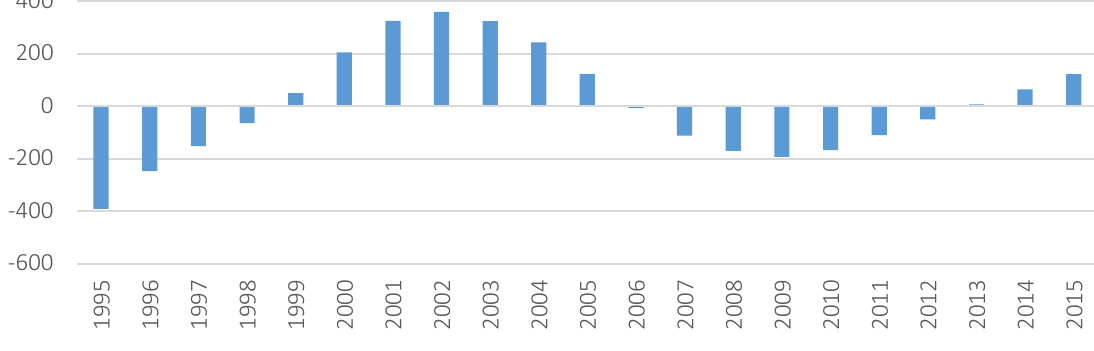
Figure 11. Deviation of the results of one-dimensional filtering from the Hodrick-Prescott multidimensional filter, million dollars